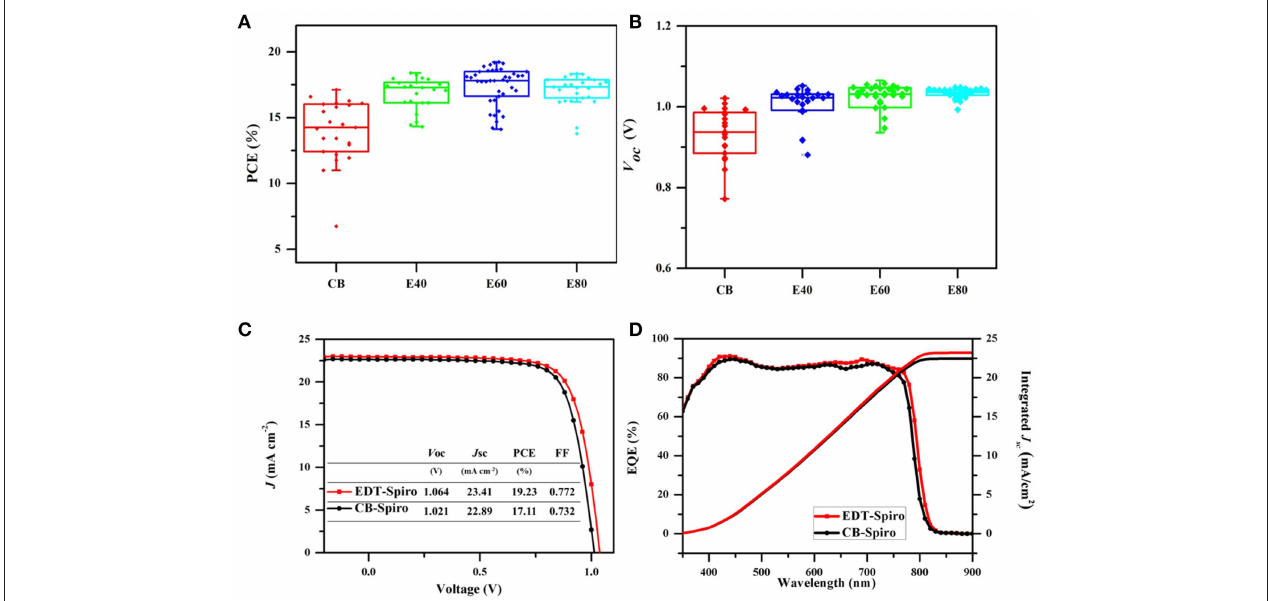
FIGURE 4 | The (A) PCE and (B) V oc of the different density EDT-Spiro solvents processed perovskite solar cells. (C) J-V curves of the CB and EDT devices under forward scan. (D) The external quantum efficiency (EQE) of the best CB and EDT devices.